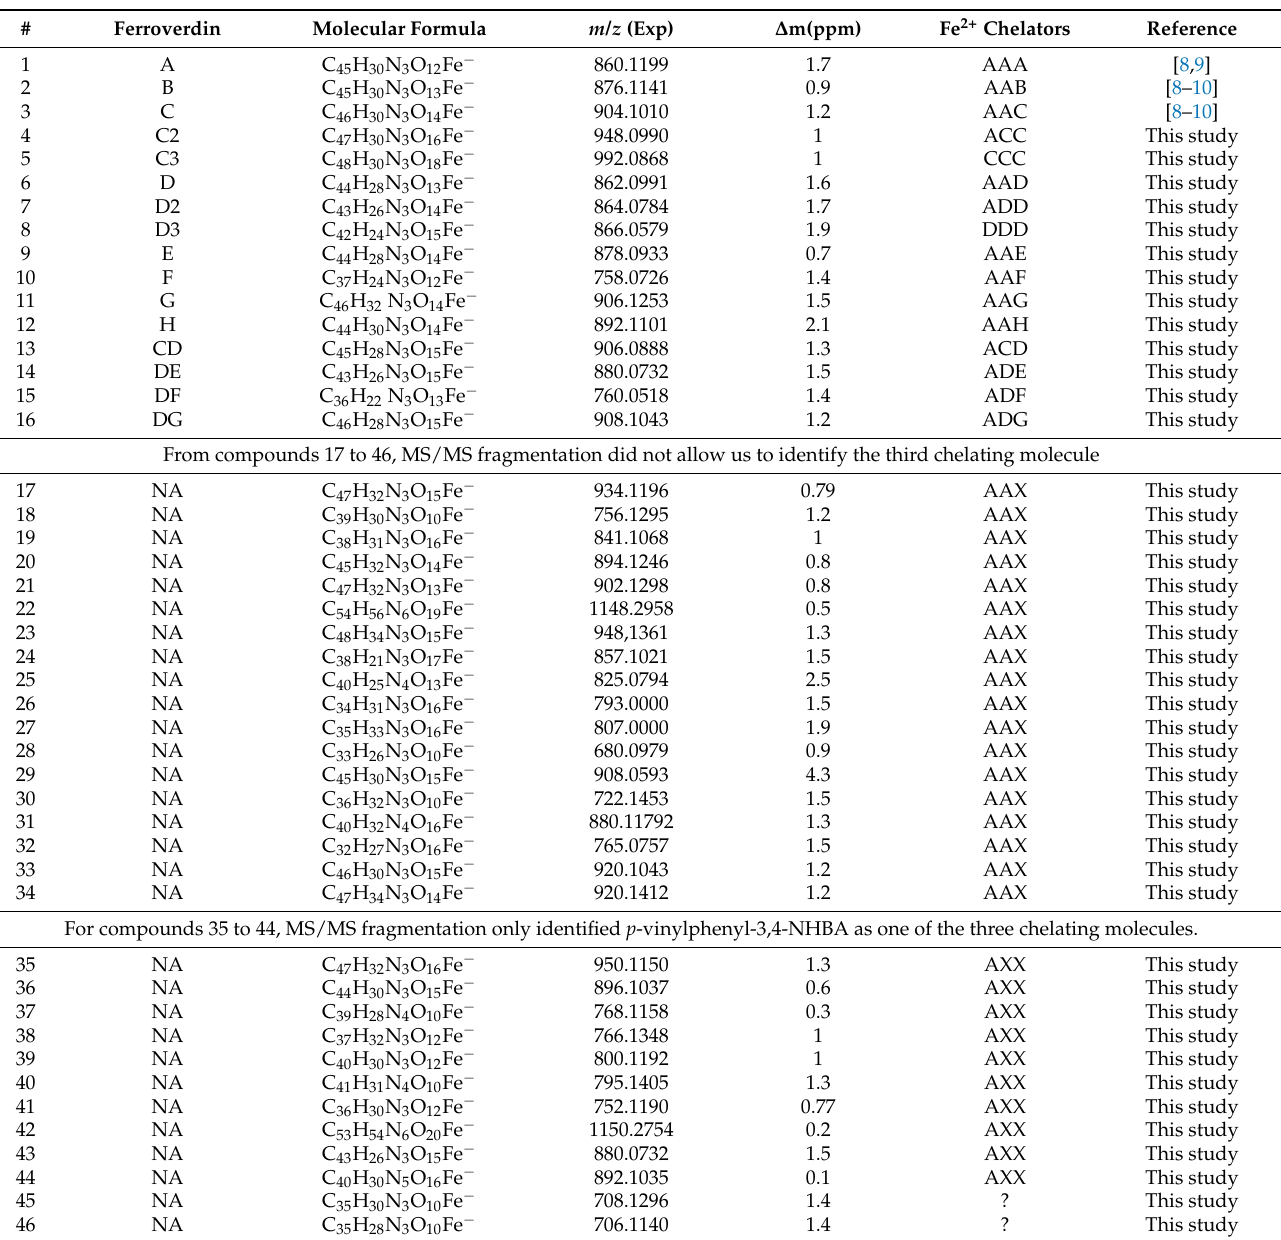
Table 1. Ferroverdin-like compounds produced by the S . lunaelactis strains MM109 T and